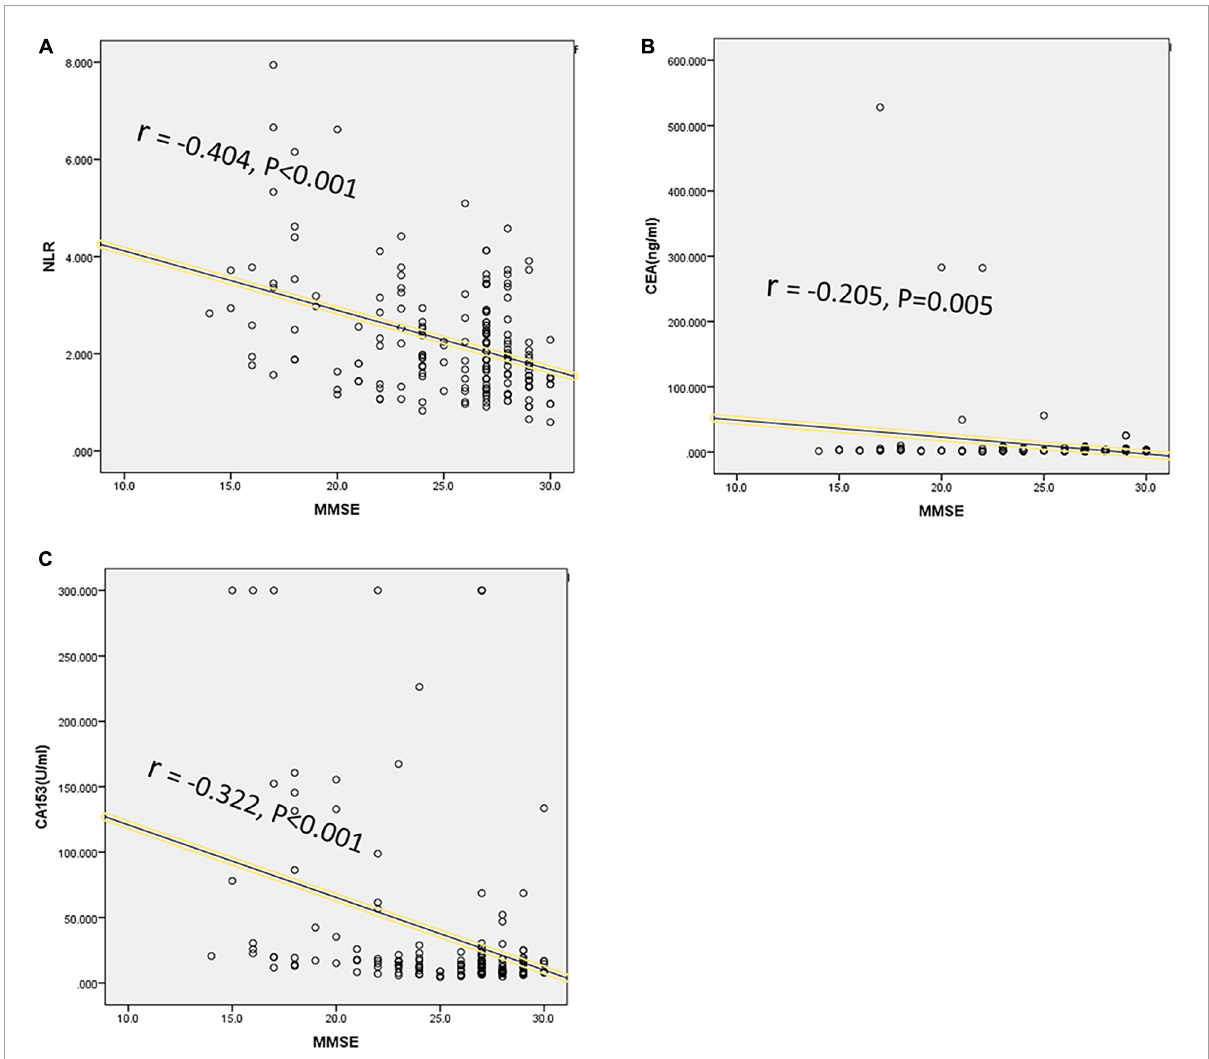
FIGURE2 Correlations between cognition and peripheral blood biomarkers levels. The MMSE score was designed to evaluate cognition, and significant correlations were analyzed between MMSE scores and peripheral blood biomarkers levels, including NLR ( r = -0.404, P < 0.001) (A) , CEA ( r = -0.205, P = 0.005) (B) , and CA153 ( r = -0.322, P < 0.001) (C)